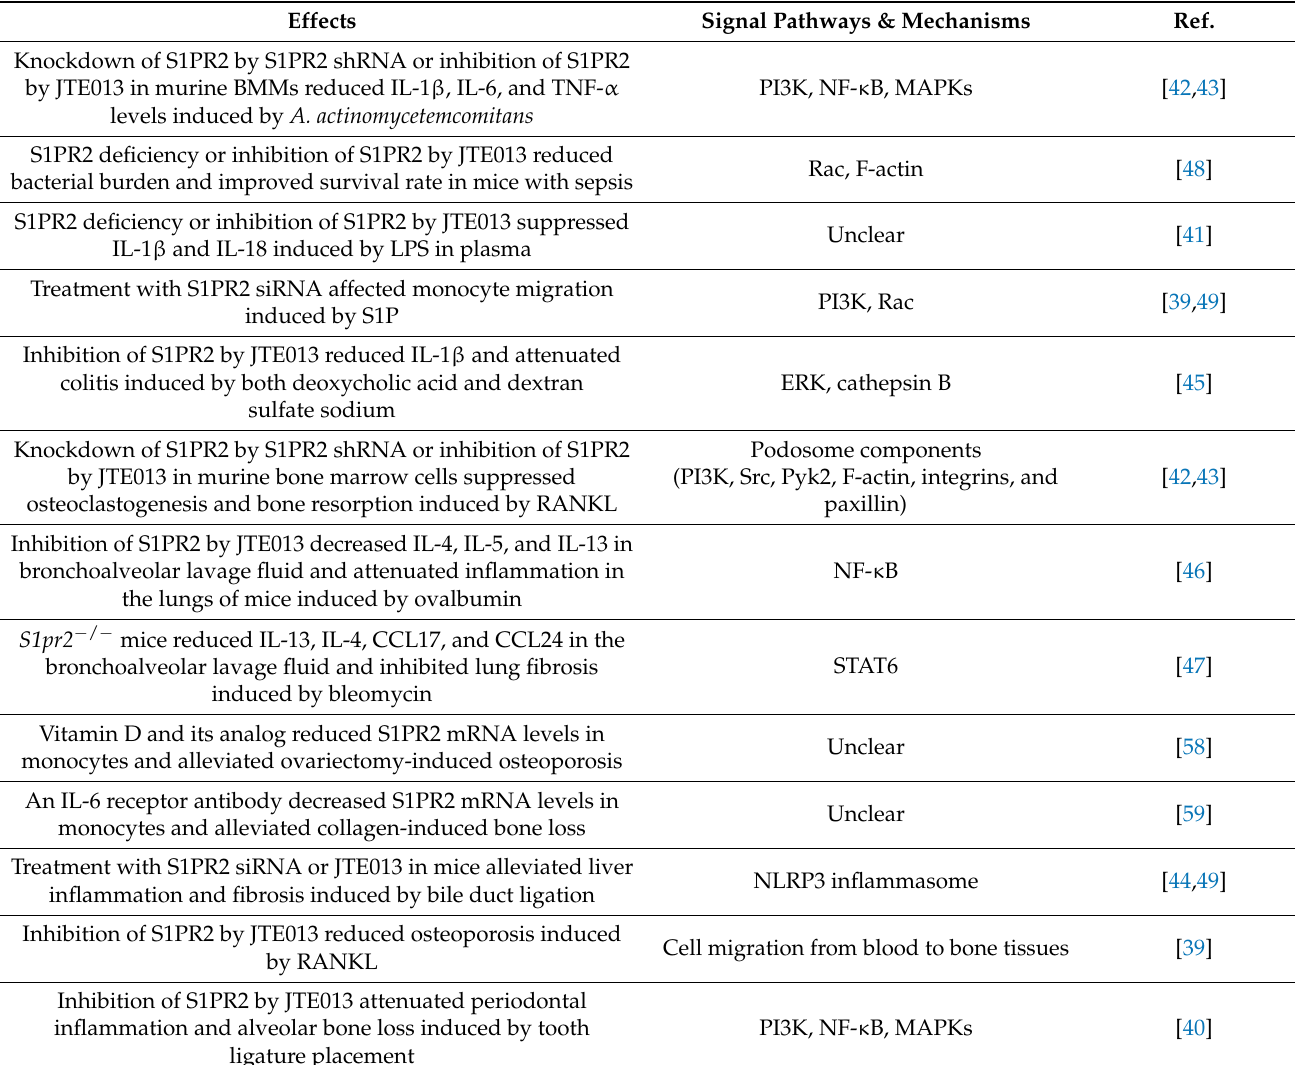
Table 1. Biological effects of S1PR2 in response to various